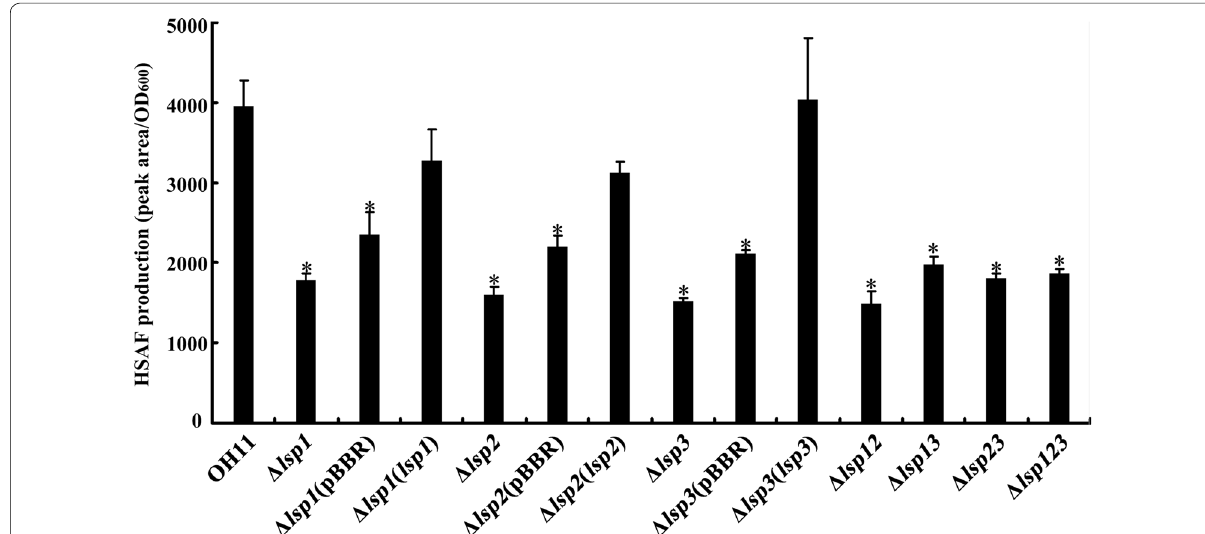
Fig. 3 Deletion of lsp genes individually or in various combinations in Lysobacter enzymogenes significantly impaired HSAF production. The identities of strains OH11, Δ lsp1 , Δ lsp2 Δ lsp3 , Δ lsp12 , Δ lsp13 , Δ lsp23 and Δ lsp123 are provided in the Fig. 2 caption. Δ lsp1 (pBBR), Δ lsp2 (pBBR), and Δ lsp3 (pBBR) are the respective mutant strain containing the empty vector, pBBR1-MCS5. Δ lsp1 ( lsp1 ), Δ lsp2 ( lsp2 ), Δ lsp3 ( lsp3 ) are the complemented strain of each mutant in which the deleted lsp gene(s) was expressed in the plasmid. The values shown in this figure represent the means of three experiments. Vertical bars represent standard errors. The asterisk above a bar indicates a significant difference ( p < 0.05) between the respective